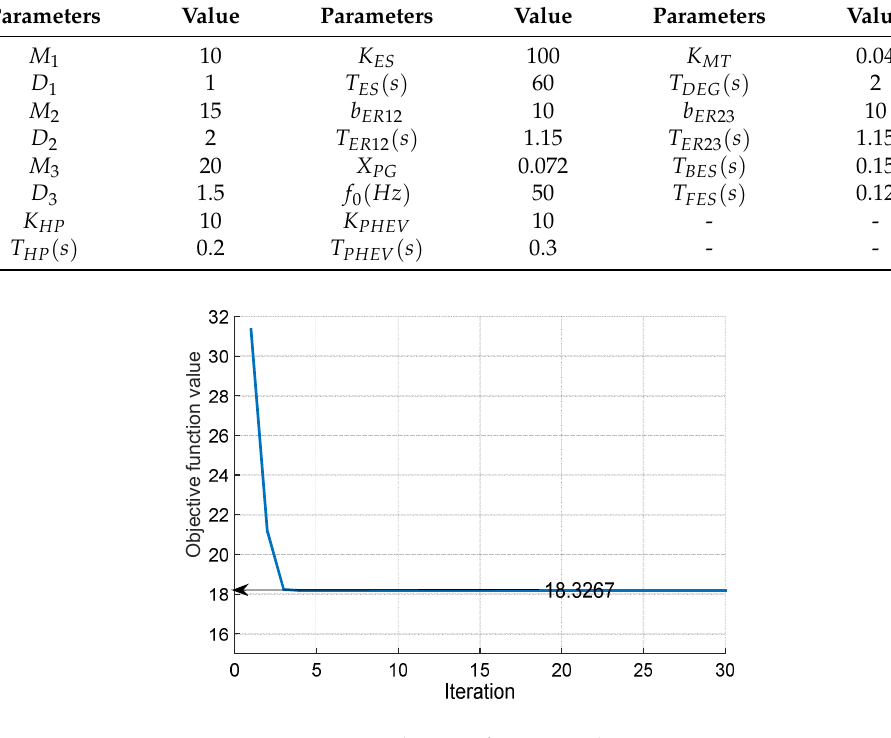
( b ) Figure 8. Local power generation and consumption; ( a ) power generation of photovoltaic (PV) units and wind turbine generator (WTGs); ( b ) power consumption of loads.